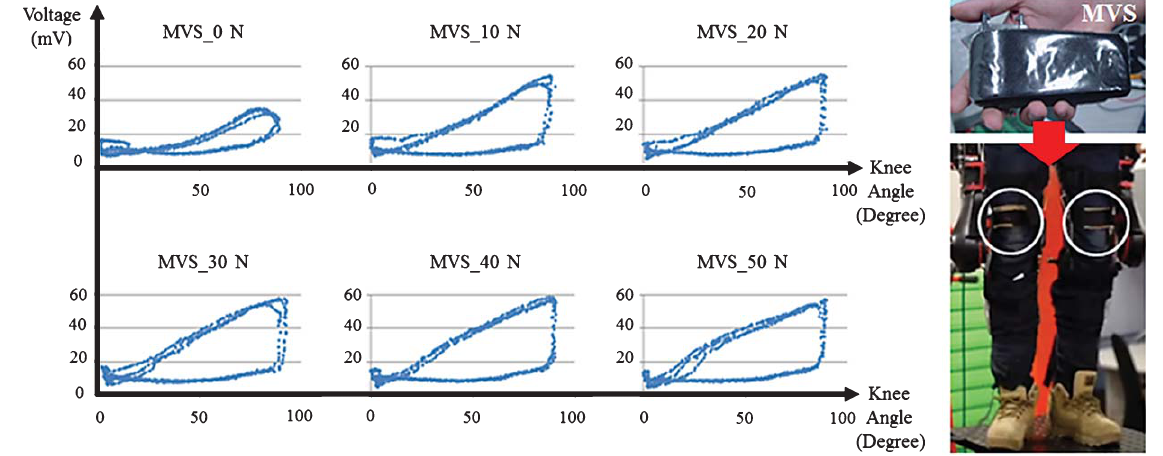
Fig. 10. Result of the performance test of the muscle volume sensor (MVS) applied to the exoskeleton